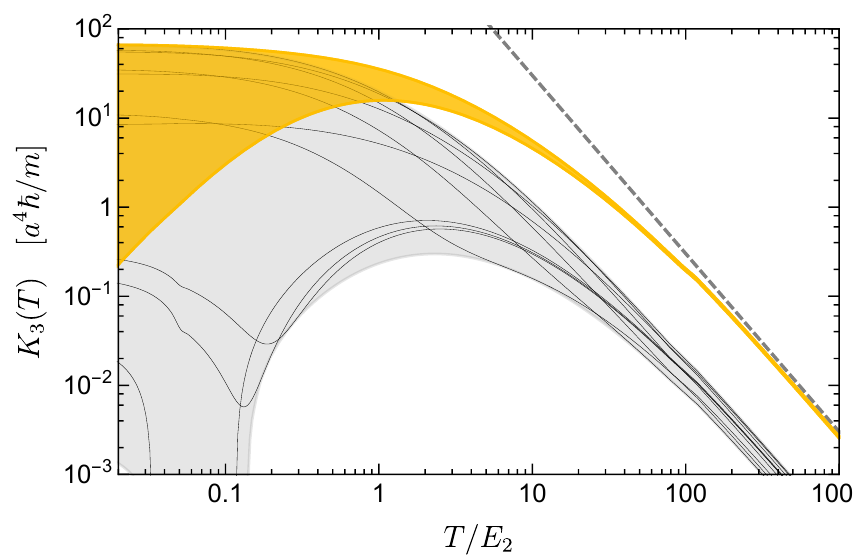
Figure 5 . Rate coe(cid:14)cient K 3 ( T ) for three-body recombination as a function of the temperature T . The upper band is the envelope of K 3 ( T ) for all possible values of the three-body parameter a + . The dashed line is the extrapolation from the scaling behavior in eq. (4.13). The lower band is the envelope of the J = 0 contribution to K 3 ( T ) for all possible values of a + . The curves inside the lower band are for 8 values of a + : a + =a = (cid:21) n= 8 , n = 0 ; 1 ; : : : ; 7. 0 where C ( a=a ) is the coe(cid:14)cient in eq. (3.10), which can be accurately approximated 3 +